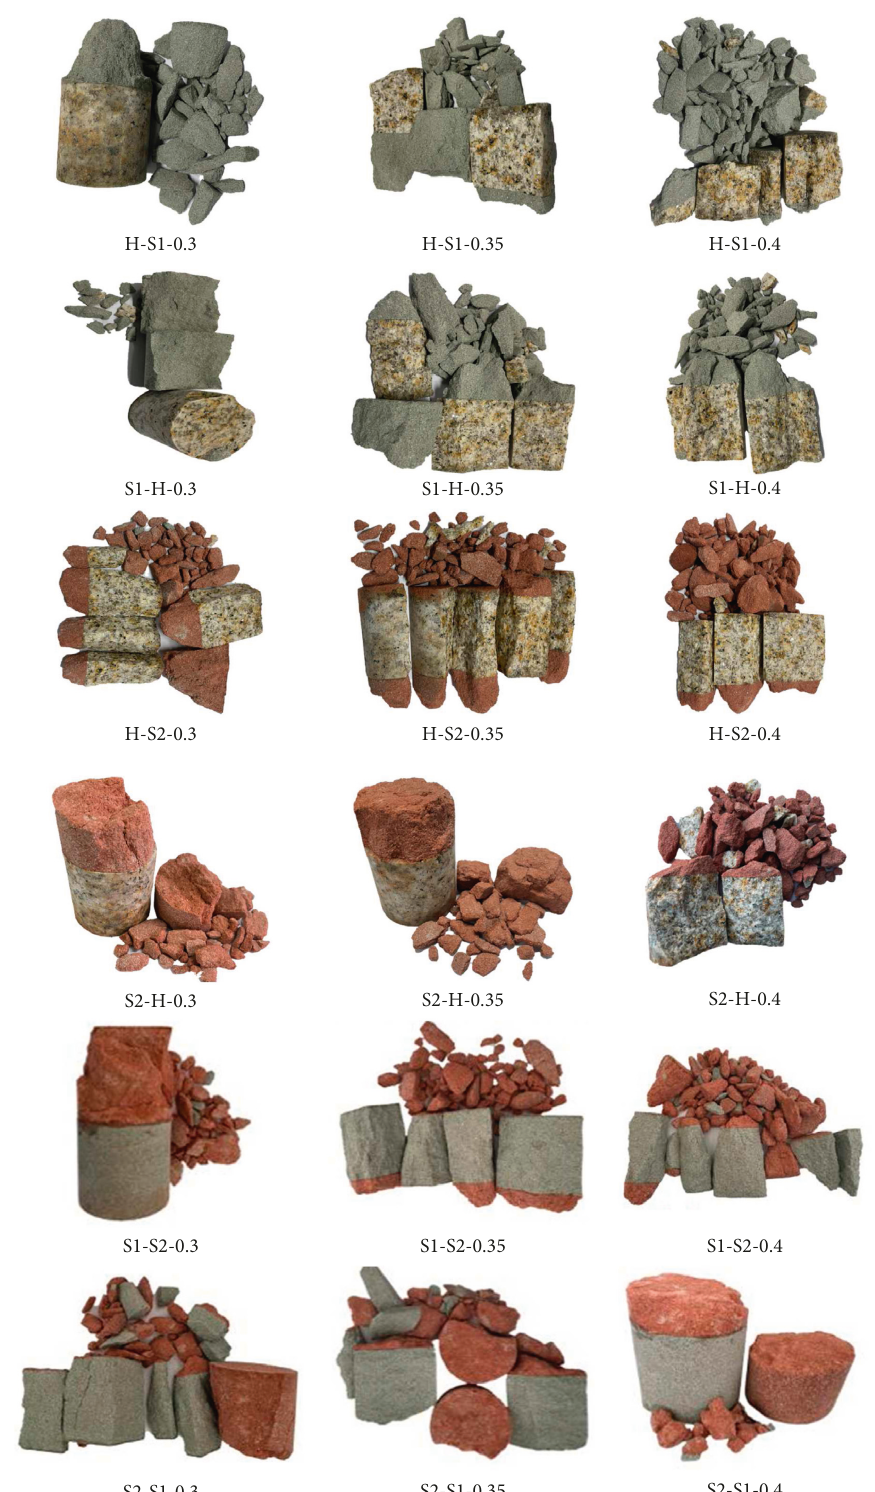
Figure 13: Failure photographs of composite samples after impact of dynamic